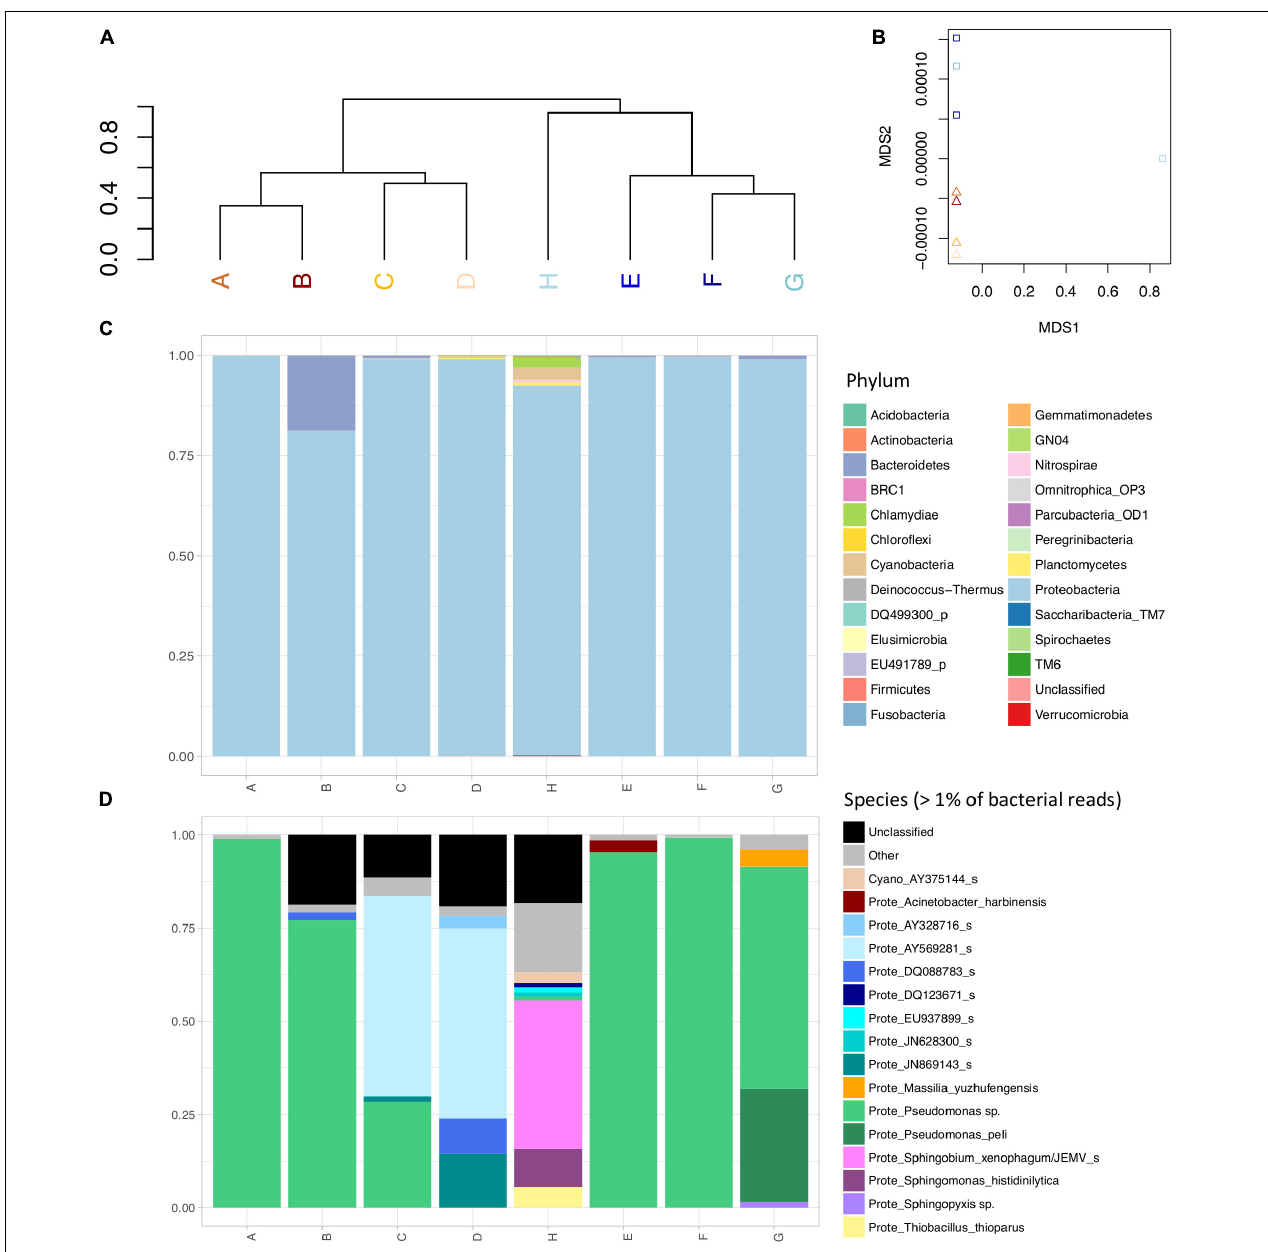
FIGURE 3 | Taxonomic classification of 16S rRNA amplicons. (A) Hierarchical clustering of samples based on the presence/absence OTUs for City#1 (brown labels) and City#2 (blue labels) sampling sites. A gradient from dark to light colors reflects chlorine concentration at each site. (B) Non-metric multidimensional scaling plot of the sample based on the presence/absence and the quantification of reads classified in bacterial OTUs (Ward distance), displayed with the same color-code as in (A) . (C) Bacterial composition at the phylum level, showing the large predominance of Proteobacteria , and some Bacteroidetes , Cyanobacteria , and Chlamydiales in a few samples. (D) Bacterial composition at the species level, showing the large predominance of Pseudomonas spp. in the samples with higher chlorine, and the abundance of unknown proteobacterial clades as well as Sphingomonales in samples with lower chlorine concentration. Only identified species encompassing more than 1% of reads were represented in (D)